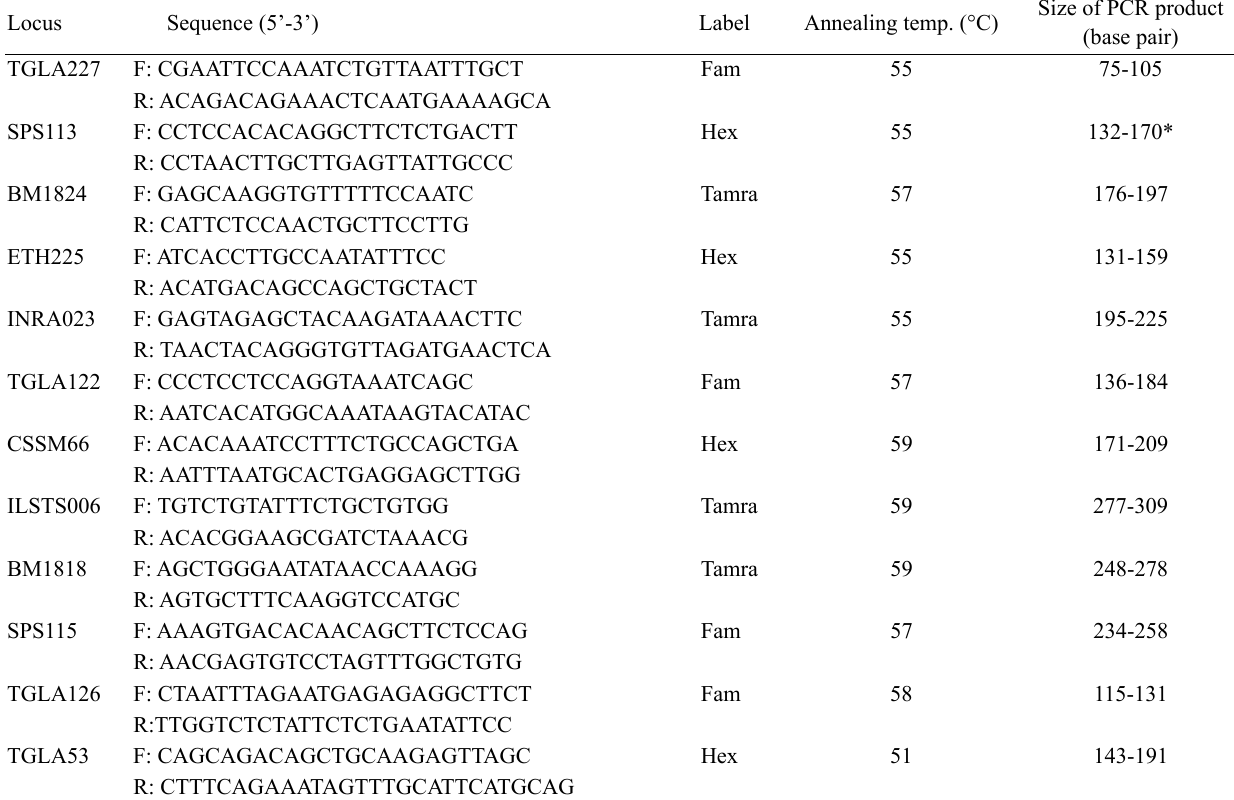
Table 1. Sequence of 12 microsatellite primers used in the study based on FAO (2011) Locus Sequence